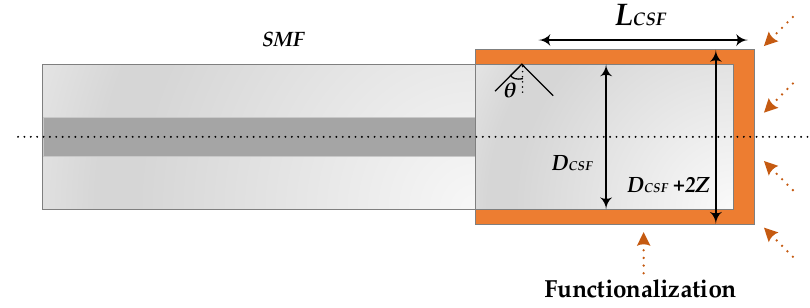
Figure 1. Schematic diagram of the sensor structure.